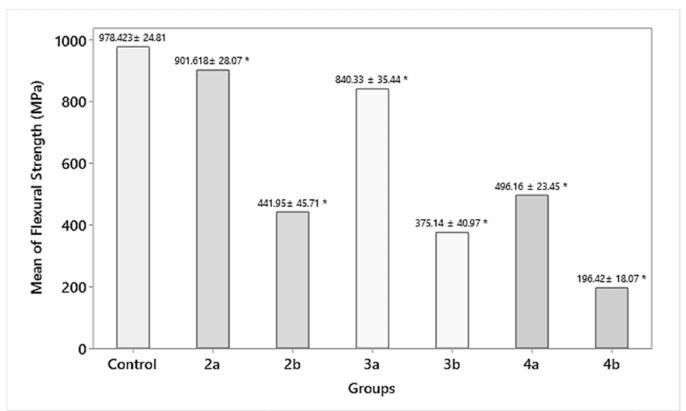
Figure 6. Flexural strength of the abraded zirconia samples (MPa). * Statistically significant difference between the groups.